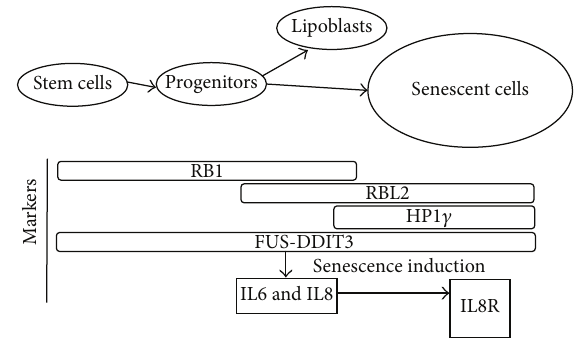
Figure 3: Schematic presentation of tumor populations and factors involved in senescence. A small population of proliferating cells arises from a hypothetical tumor stem cell population. Most of these cells enter senescence and a few percent differentiates into lipoblasts. RB1 and RBL2 proteins are central factors involved in growth regulation and entry/maintenance of cell senescence. RB1 is expressed in proliferating cells and is also necessary for differentiation and senescence. RBL2 is expressed in resting and senescent cells. Increased HP1 𝛾 expression is typical for senescent cells. IL6 and IL8 are produced by the tumor cells and IL8 may bind to the IL8 𝛽 receptor expressed by senescent tumor